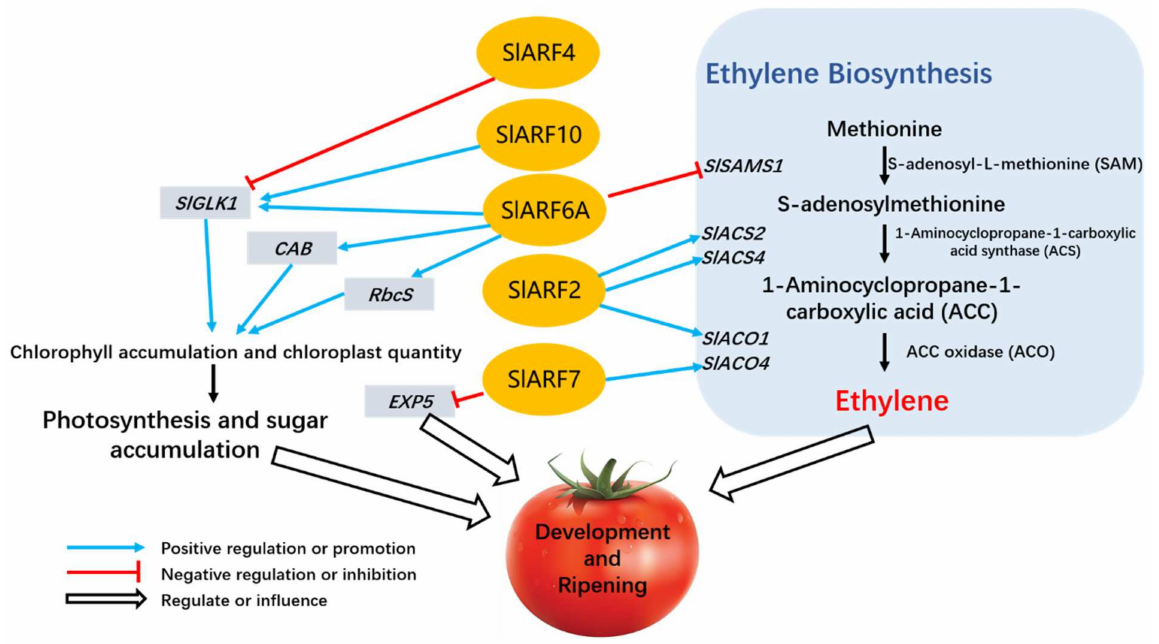
Figure 3. A model of ARFs regulating tomato fruit development and ripening. Several members of the auxin responsive factor family influenced the development and ripening of tomato fruits by regulating the expression of genes related to ethylene biosynthesis and chlorophyll accumulation. SlARF2 regulates ethylene synthesis and tomato ripening by regulating the expression of ethylene biosynthesis genes ACO1/ACS2/ACS4. GOLDEN2-LIKE transcription factor SlGLK1 plays an important role in chloroplast formation and chlorophyll accumulation. SlARF4 inhibits the expression of its encoding gene SlGLK1, while SlARF10 and SlARF6A promotes its expression. Moreover, SlARF6A also targets the promoters of CAB (genes encoding chlorophyll A/B binding) and RbcS (gene encoding ribulose bisphosphate carboxylase small chain), genes that affect chlorophyll accumulation, and positively regulates the expression of these genes. SlARF6A is also a negative regulator of SAMS1, which in turn negatively regulates ripening and ethylene biosynthesis in tomato fruit. EXPANSIN5 (EXP5) likely promotes cell expansion during fruit development. SlARF7 inhibits tomato fruit set and early development by directly regulating EXP5 and